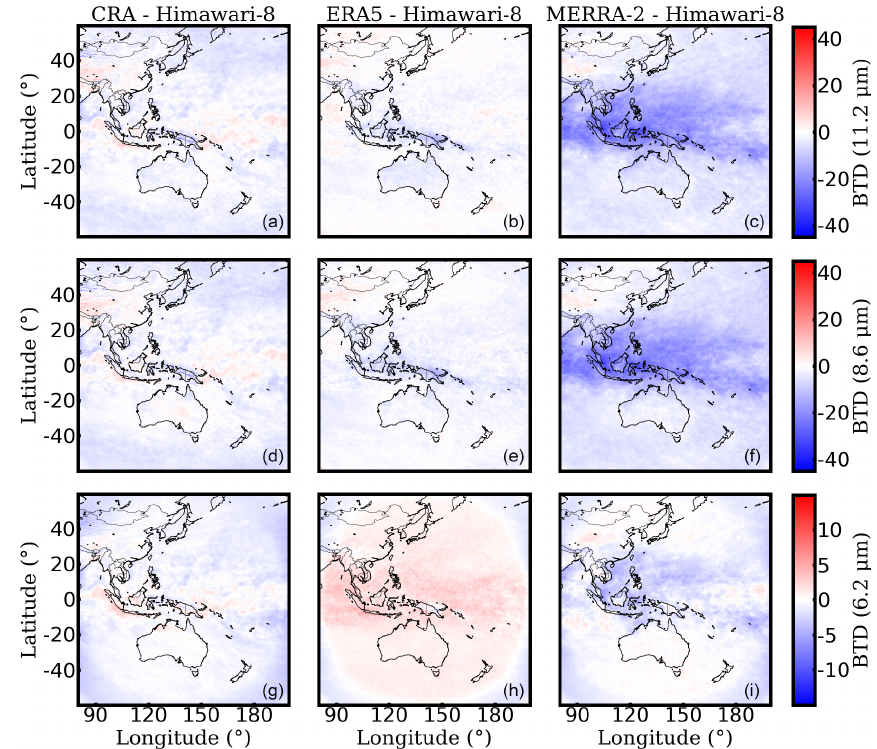
Figure 11. Average result of brightness temperature differences between the observations and simulations in the 11.2µm (a, b, c) , 8.6µm (d, e, f) , and 6.2µm (g, h, i) channels. The observations and simulations are from the 144 realizations spanning 2016.